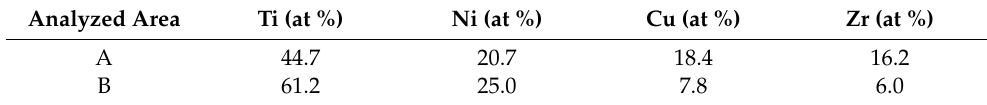
Table 3. EDS analysis (at %) of the selected area of the alumina/BTi-5 sample (Figure 4). Analyzed Area